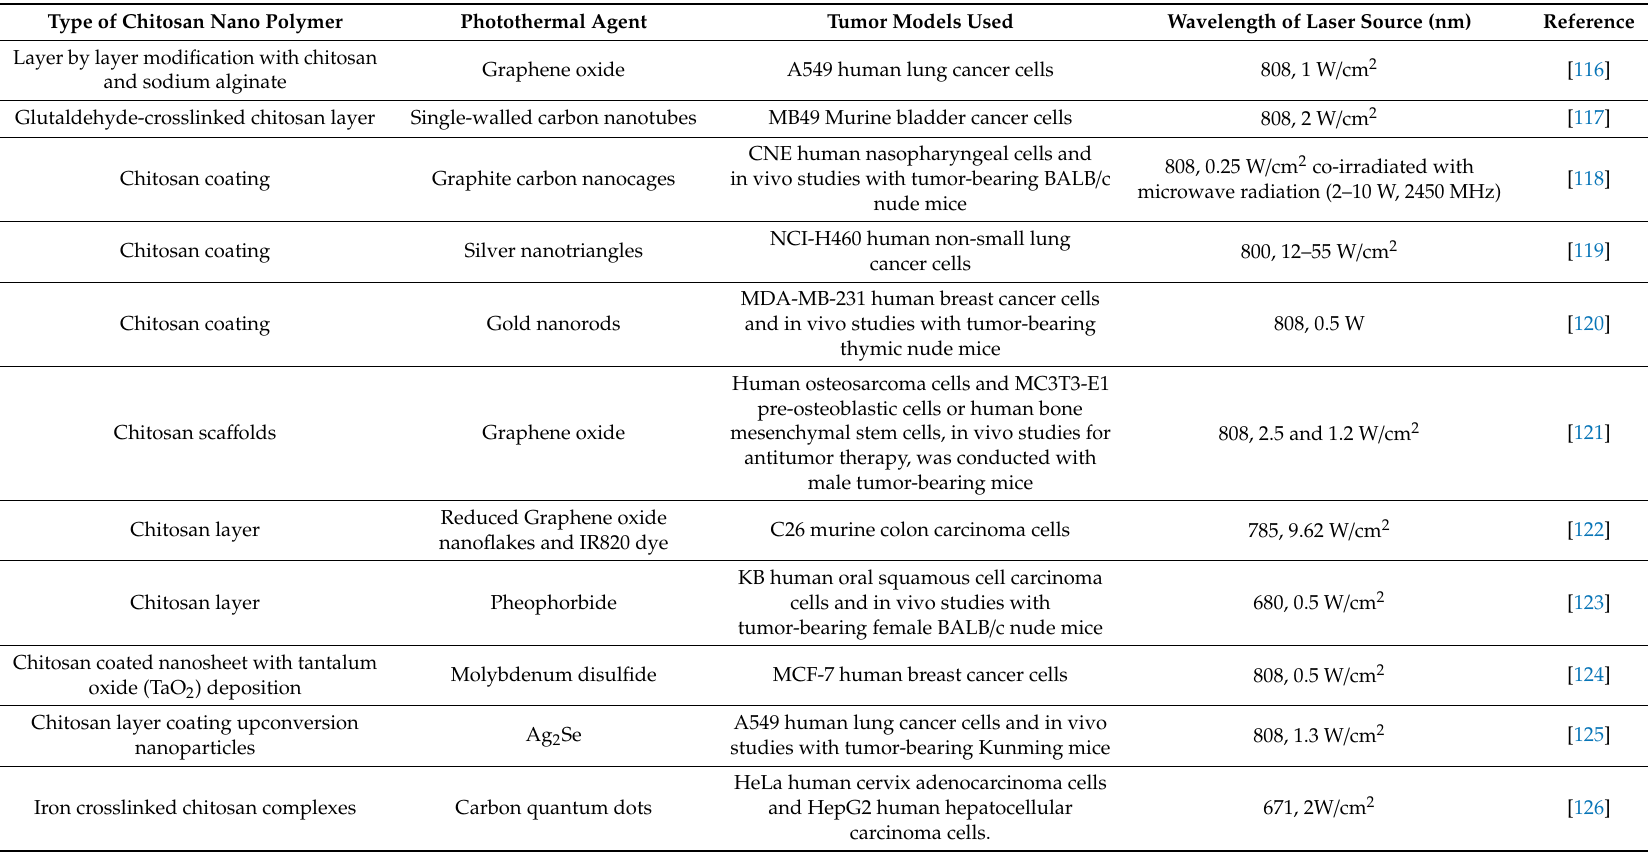
Table 5. Applications of nanochitosan in cancer photothermal